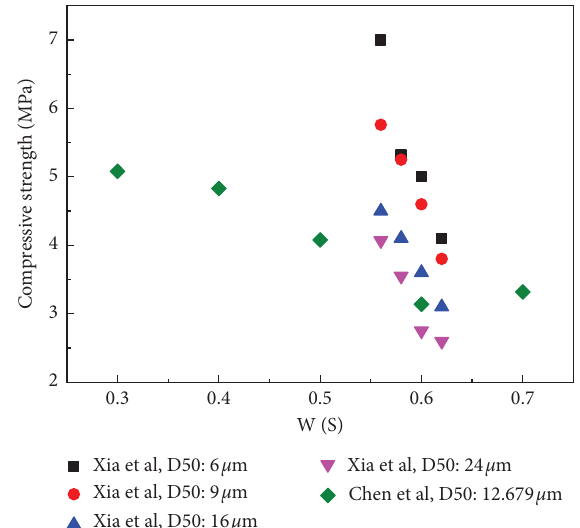
Figure 4: Infuence of fneness of CFB fy ash and W/S ratio on compressive strength of CFB fy ash AAC [54,